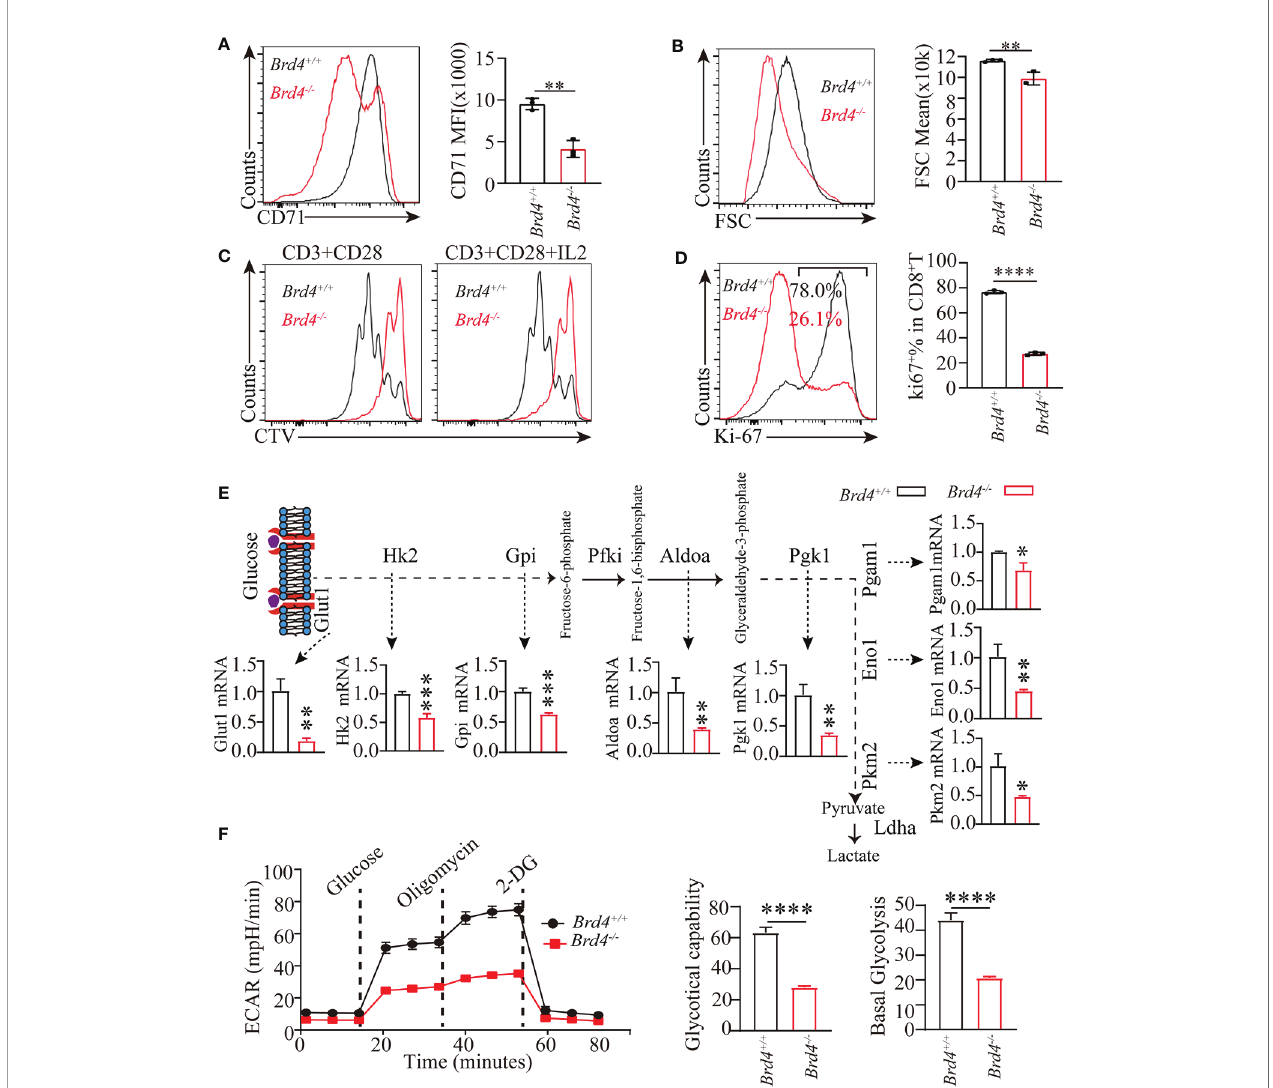
FIGURE 6 | Brd4 promotes CD8 + T cell proliferation through inducing glycolysis. (A) Puri fi ed Brd4 +/+ and Brd4 -/- naïve CD8 + T cells were activated with anti-CD3/28 antibody for 24 hours to assess cell activation. Flow cytometry showing the expression of CD71 after stimulation (left) and the quanti fi cation of CD71 MFI (right). (B) Flow analysis of cell size of in vitro -activated CD8 + T cells. (C) Puri fi ed Brd4 +/+ and Brd4 -/- naïve CD8 + T cells were labeled with CellTrace Violet (CTV) and activated with anti-CD3/28 antibody in the presence or absence of IL-2 for 3 days to assess cell proliferation. Flow cytometry showing CTV dilution. (D) Intracellular staining showing the expression of Ki-67 in Brd4 +/+ and Brd4 -/- CD8 + T cells after activation for 24h (left) and the quanti fi cation of Ki-67 + CD8 + T cells (right). (E) qPCR analysis showing the differentially expressed glycolytic genes in Brd4 +/+ and Brd4 -/- CD8 + T cells. (F) Chart showing glycolysis measurement of in vitro - activated CD8 + T cells (left) and the quanti fi cation of the basal and maximal glycolysis (right). Two-tailed unpaired t -test was used to analyze two independent groups. Results were indicated as mean ± sem (error bars). *p < 0.05; **p < 0.01; ***p < 0.001; ****p < 0.0001. Each group includes at least 3 mice and each experiment repeats more than 2